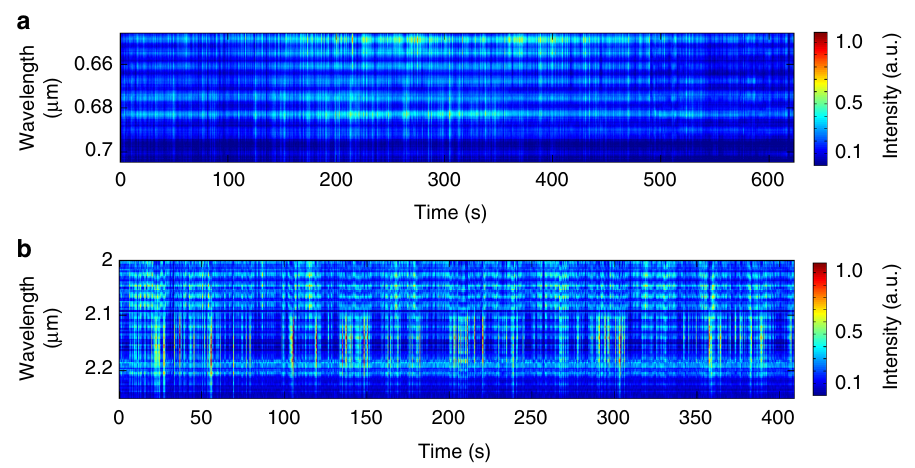
Fig. 4 Characterisation of shot-to-shot carrier-envelope phase stability. a The measured self-referencing f- 3 f spectral interferometry (SI) of the 2.1- µ m pump pulse over 10 min. Shot-to-shot carrier-envelope phase (CEP) jitter (220 mrad) is measured over 10 min. b The measured cross-referencing f -3 f SI of the idler pulse, between the polarisation-rotated ~2.1- µ m pump and the third harmonic of the idler at ~6.4 µ m over 6 min. Shot-to-shot CEP jitter (270 mrad) of the idler pulse over 6 min is calculated with the measured phase jitters of pump and the cross-referencing SI